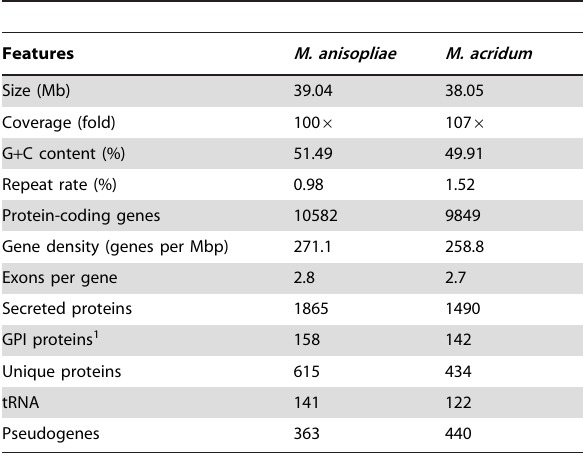
Table 1. Main features of the M. anisopliae and M. acridum